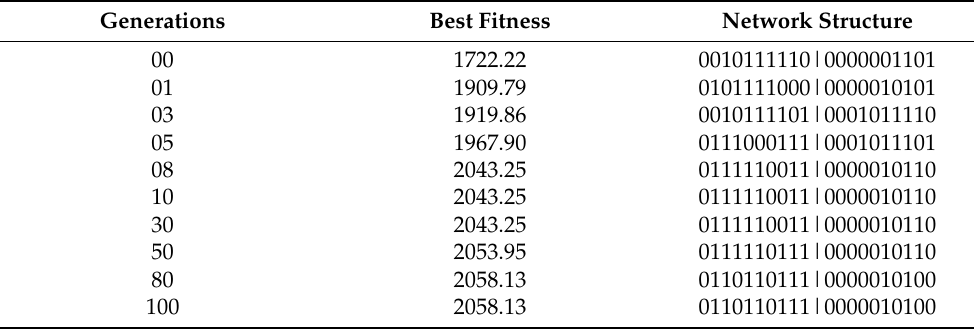
Figure 5. The generations and corresponding best fitness in Dataset 2. Table 8. The best fitness and corresponding network structure in Dataset 2.